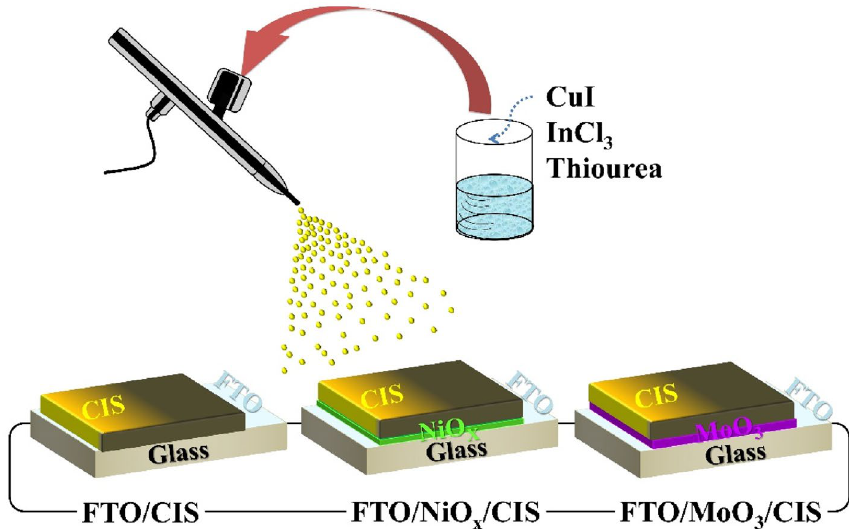
Figure 1. Schematic presentation of the spray deposition